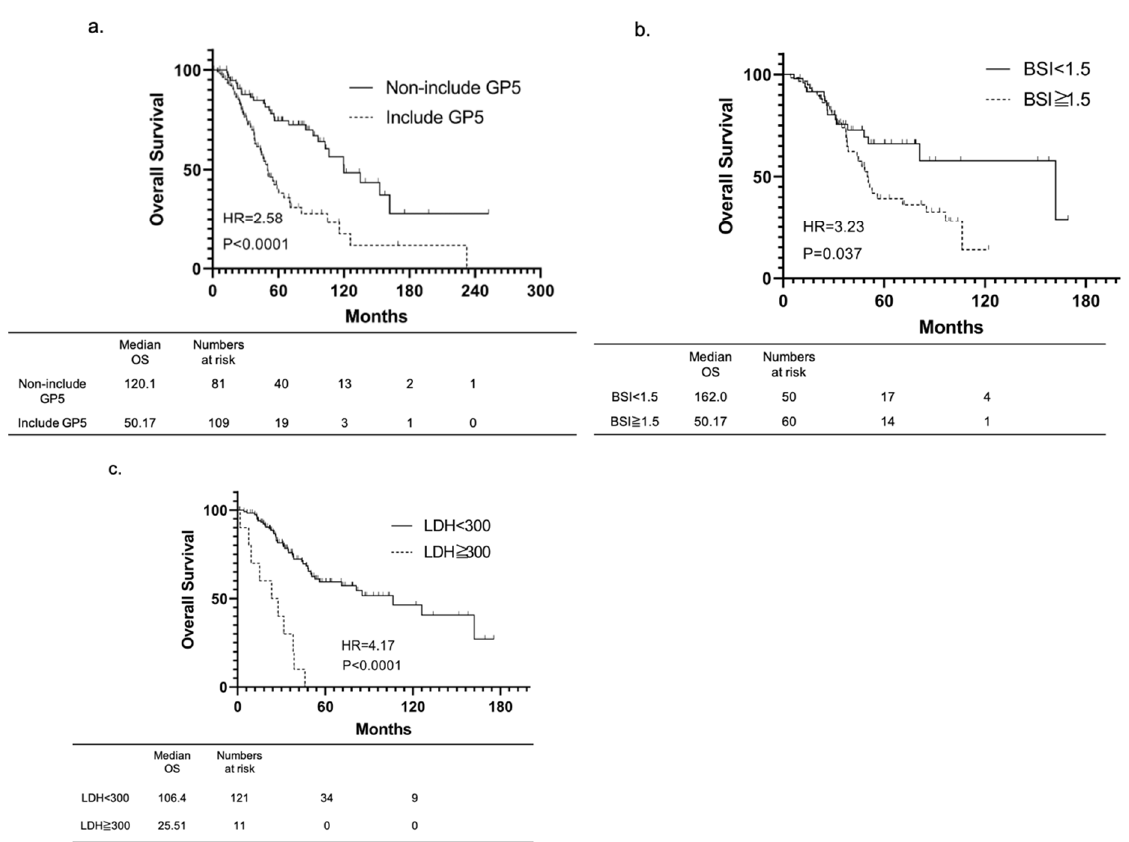
Figure 2. Kaplan-Meier showing the difference in OS stratified by inclusion of GP5, BSI ≧ 1.5, and LDH ≧ 300 IU/L. OS was significantly shorter with GP 5 inclusion (HR: 2.58, 95% CI 1.72–4.47; p < 0.001) than with GP 5 exclusion ( a ); in the BSI ≥ 1.5 group (HR: 3.23, 95% CI 1.77–5.89; p = 0.037) than in the BSI < 1.5 group ( b ); and in the LDH ≥ 300 IU/L group (HR: 4.17, 95% CI 2.10–8.30; p < 0.0001) than in the LDH < 300 IU/L group ( c ). Patients for whom information was available on each identified risk factors were selected. GP: Gleason pattern; BSI: bone scan index; LDH: lactate dehydrogenase.